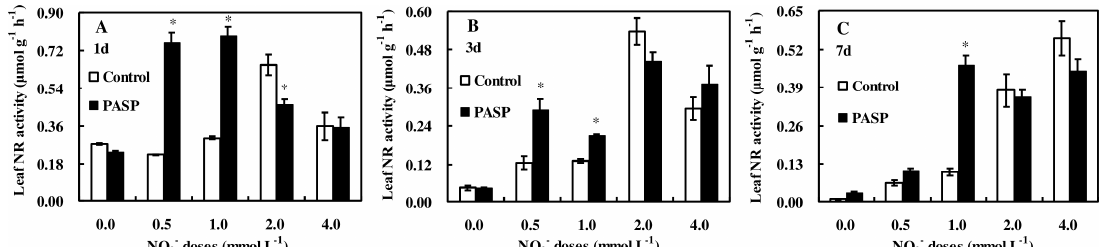
Figure 3. Changes in leaf nitrate reductase activities on the 1st ( A ), 3rd ( B ), and 7th ( C ) day after PASP treatment. The PASP and control indicate seedlings with and without PASP addition, respectively. Data were presented as the mean ± standard error of 15 plants in each treatment. *, Statistically significant differences between PASP treatment and control within each nitrogen level, according to Student’s test at p < 0.05.